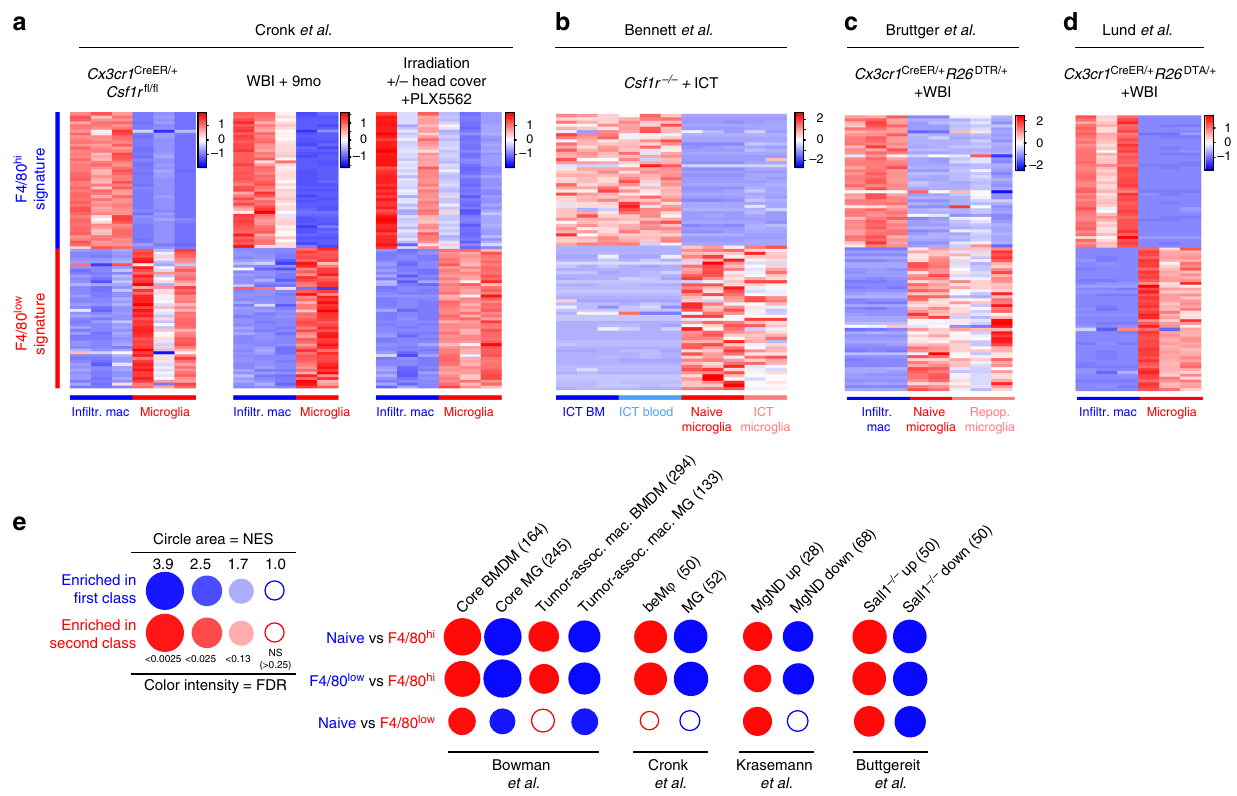
Fig. 6 Monocyte-derived macrophages adopt a conserved gene signature associated with neuroin fl ammation and neurodegeneration. a – d Expression ( z -scores) of the F4/80 low and F4/80 hi gene signatures from Fig. 5d in published datasets. These studies were chosen because they compared the transcriptomic pro fi les of CNS-in fi ltrating macrophages with resident microglia, with or without microglial depletion. Normalized RNA-seq expression counts were used to plot the data. WBI whole body irradiation. ICT intracerebral transplantation. e Gene set enrichment analysis visualized using BubbleGum. Color indicates the cell subset showing enrichment, and the size and color of circles represent enrichment score and signi fi cance, respectively. Numbers in parentheses denote the number of genes in the gene set. BMDM bone-marrow derived macrophage MgND neurodegeneration-associated